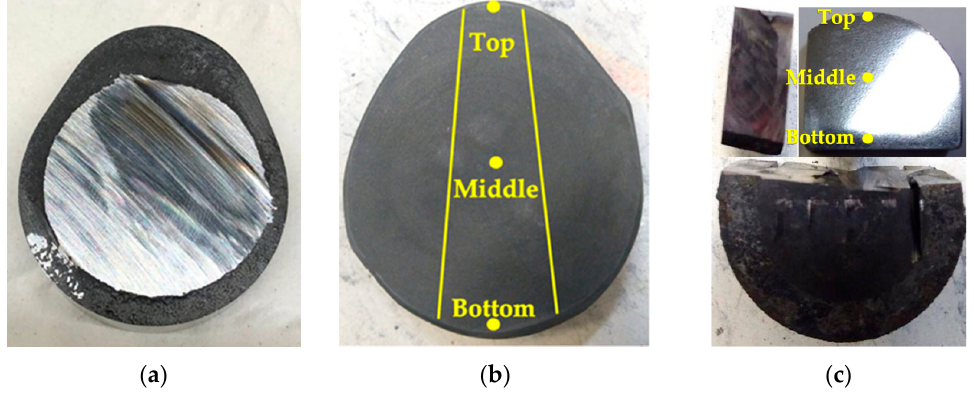
Figure 2. Lobe sectioned for microstructural characterization. ( a ) Lobe sample after cutting, ( b ) regions analyzed for the as-cast condition, and ( c ) regions analyzed for the CADI produced.